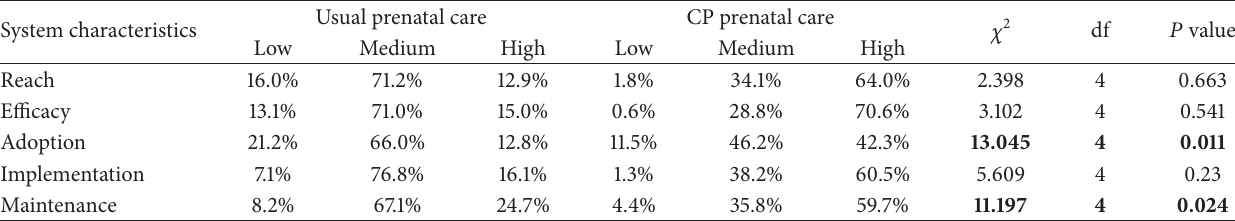
Table 4: System level differences: RE-AIM.